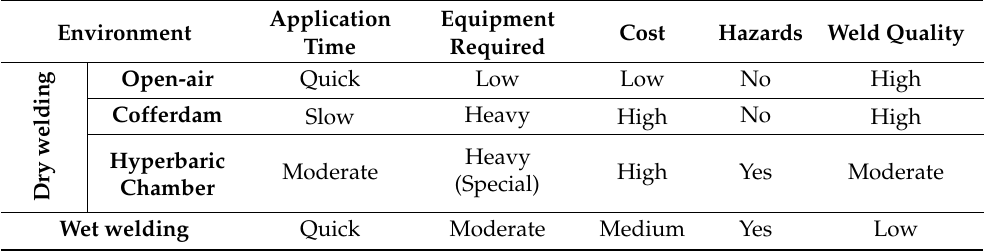
Table 1. Characteristics of various weld processes.